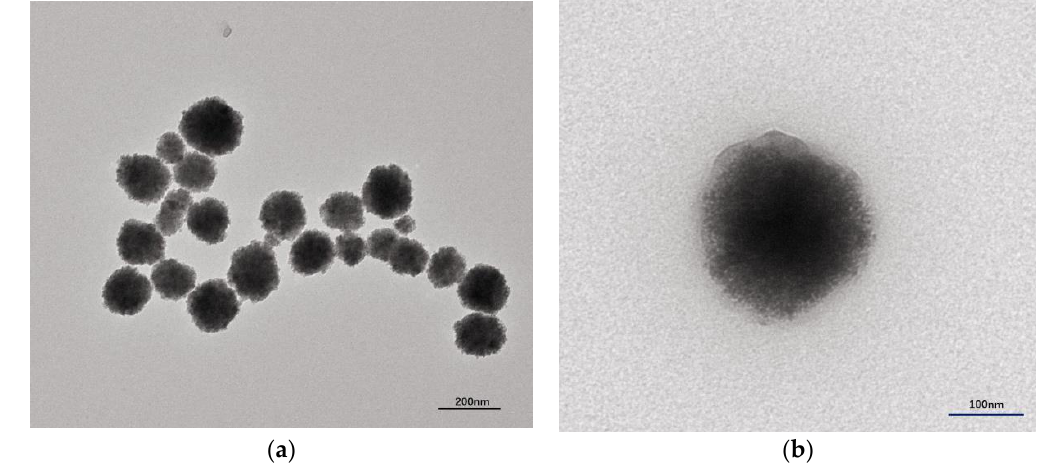
Figure 2. TEM images of ( a ) FeO x /ZnS NPs and ( b ) FeO x /ZnS@MIPs.